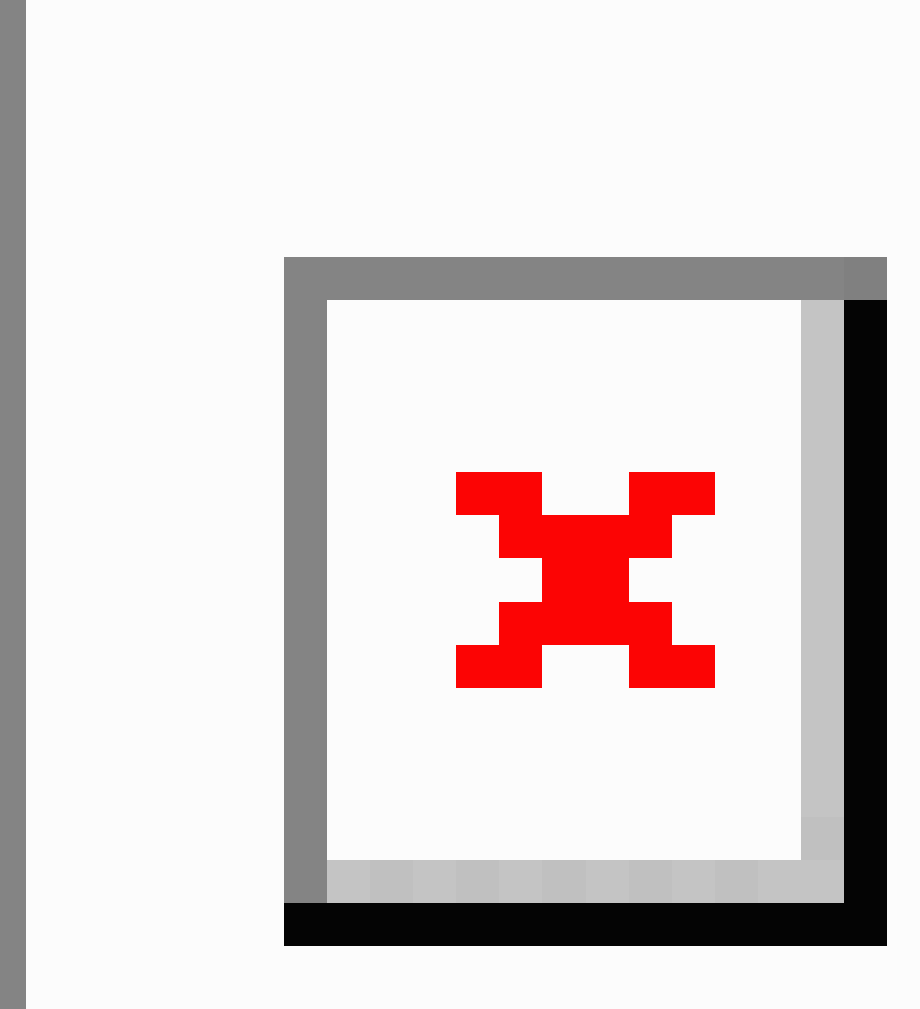
Figure 12. Community